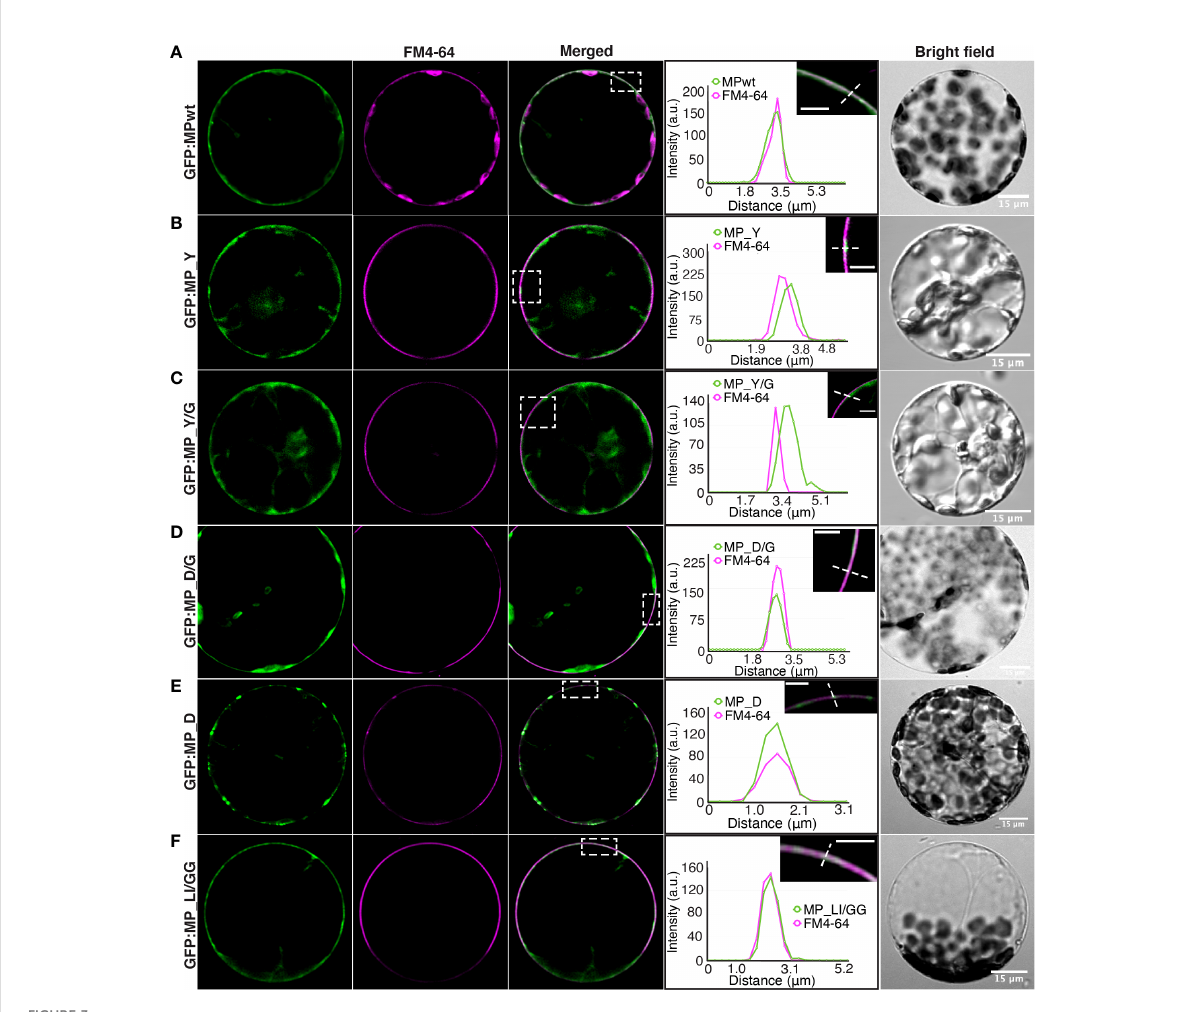
FIGURE 3 Plasma membrane localization of MP mutants. N. benthamiana protoplasts expressing (A) GFP : MPwt or GFP : MP mutants, (B) GFP : MP_Y, (C) GFP : MP_Y/G, (D) GFP : MP_D/G, (E) GFP : MP_D and (F) GFP : MP_LI/GG along with RdRp and CP. Protoplasts were stained with FM4-64, a plasma membrane marker (magenta). Selected regions (white rectangles) showing the intensity pro fi le of the diagonal line were generated by ImageJ. Images represent single optical planes. Scale bar, 5 m m (magni fi ed